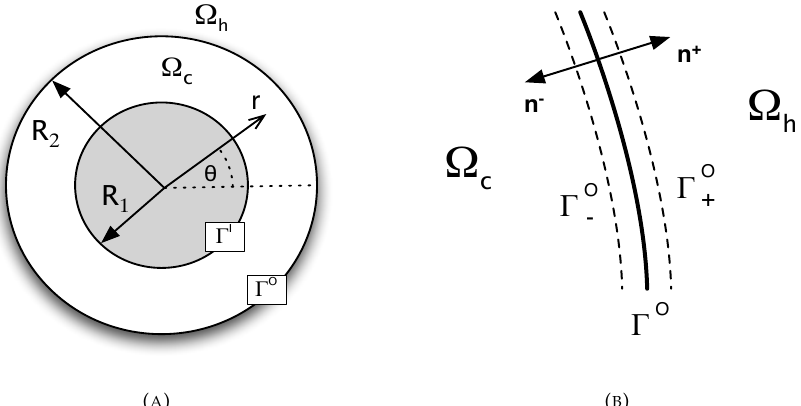
Figure 1. Nomenclature of the computational domain ( A ) and detail of the cloak/host interface ( B ).